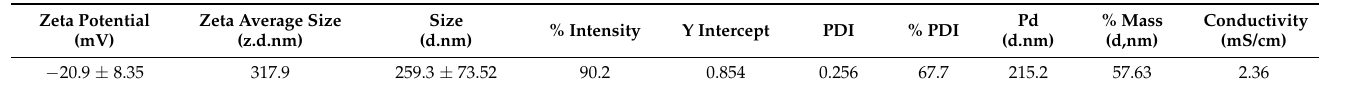
Table 1. Dynamic light scattering analysis of Amikacin sulfate loaded dextran sulfate sodium